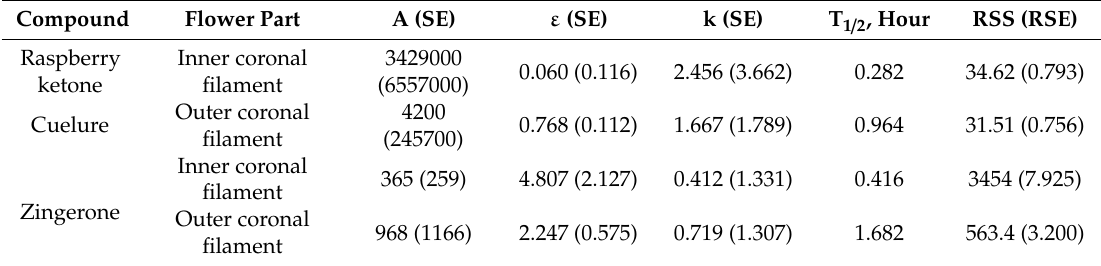
Table 2. Parameters from the curve fitting results for raspberry ketone, zingerone and